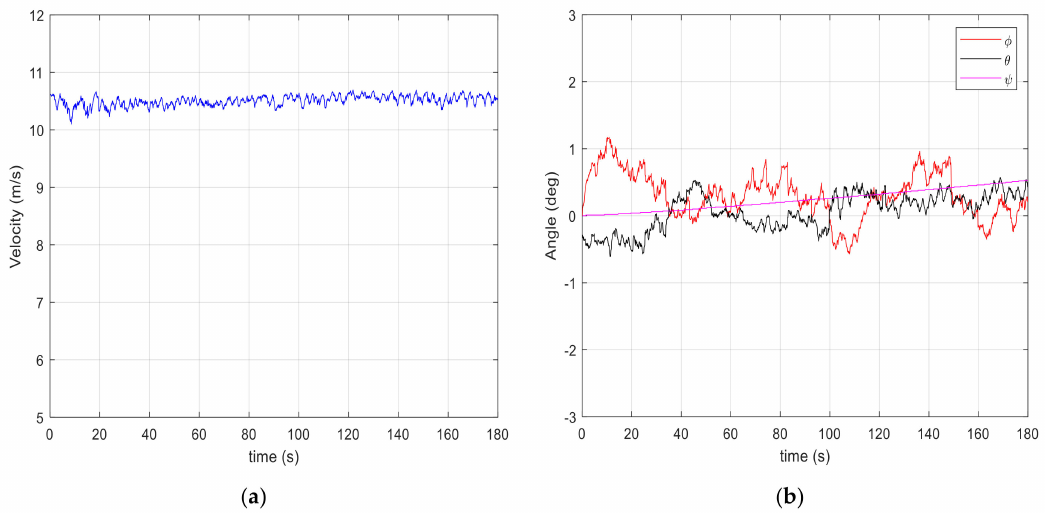
Figure 16. The filtered velocity ( a ) and filtered Euler angles ( b ) during test case